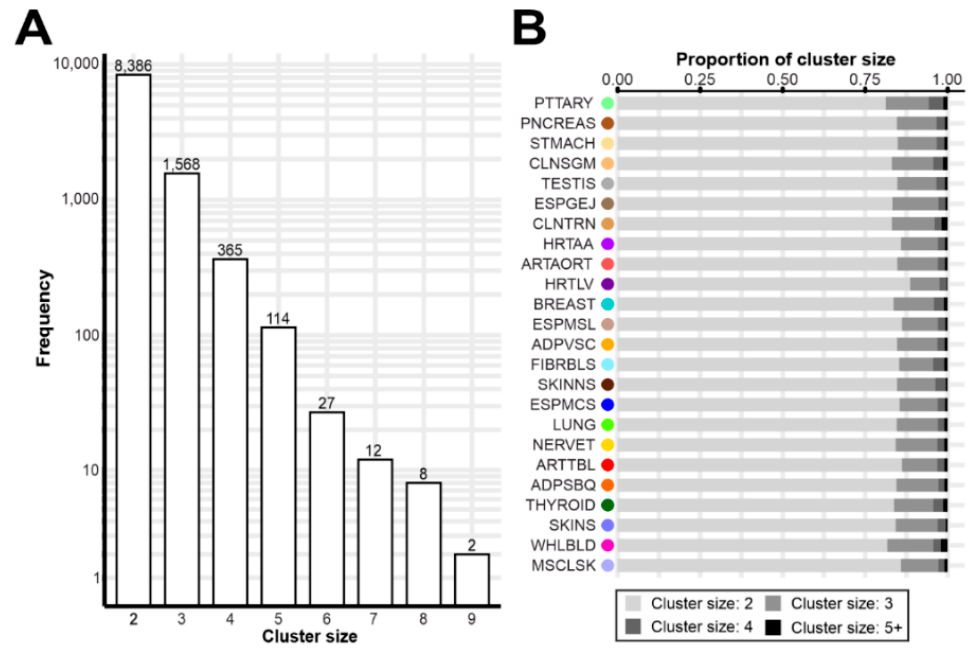
Figure 3. Cluster sizes and distribution. ( A ) Histogram representing the sizes of clusters of gene expression regulation by logarithmic scale. Only tissues with a sample size above 200 were considered and clusters, which were identified identically in multiple tissues were included only once. ( B ) Relative distribution of cluster sizes within tissues. The grey scale represents the size ranging from 2 (light grey) to above 5 (5+, dark grey). A detailed list of tissues analyzed, and their respective abbreviations, is given in Table S1.